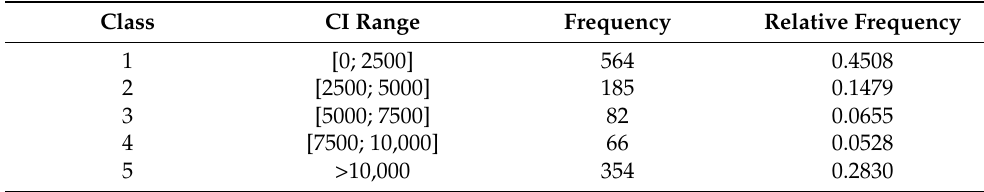
Table 2. Frequency of collapse index per pixel in 2014 (only pixels with CI >